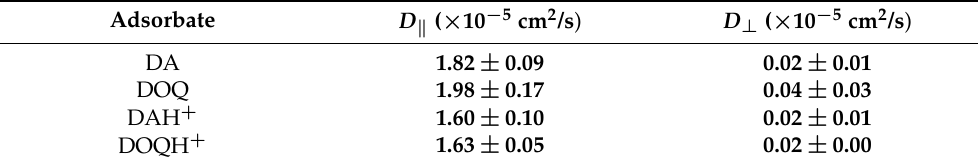
Table 3. Diffusion coefficients of DA, DOQ, DAH + , and DOQH + in a solvated CNT groove. The CNT groove results shown here are reported directly from the finite 100 Å-long CNT